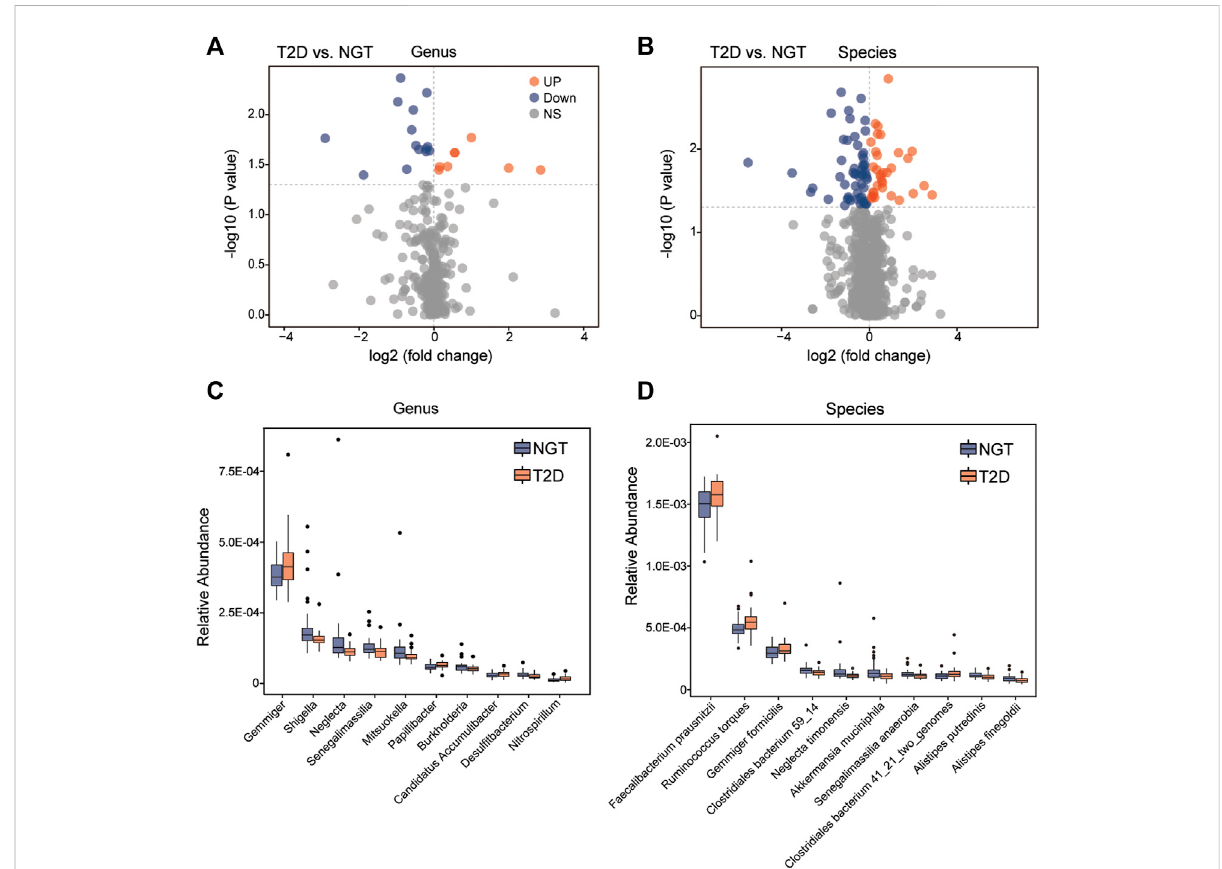
FIGURE 5 Abundance comparisons of candidate LPS-producing bacteria across the NGT and T2D groups. (A,B) Twenty-two genera, and 89 species harboringLPS-biosynthesis-relatedenzymaticgeneswereidenti fi edtobesigni fi cantlydifferentbetweenindividualswithNGTandpatientswithT2D usingvolcanoplots,respectively.Orangeandblueindicatesigni fi cantenrichmentandreductionintheT2Dgroup,respectively;graydenotesanon- signi fi cant difference between the two groups. (C,D) Box plots showing the relative abundance of the top 10 gut genera and species with both genes for LPS-biosynthesis-related enzymes, and statistical difference between the NGT and T2D groups. Boxes represent the interquartile ranges, the inside lines represent themedian, and circles represent outliers. Orange and bluerepresent enrichment in patients with T2D and individuals with NGT, respectively. T2D, type 2 diabetes; NGT, normal glucose